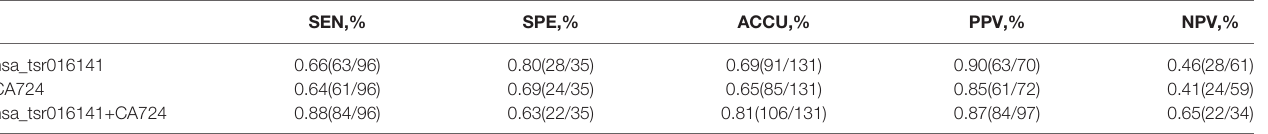
TABLE 5 | Use the expression levels of hsa_tsr016141 and CA724 to distinguish GC patients from gastritis patients.